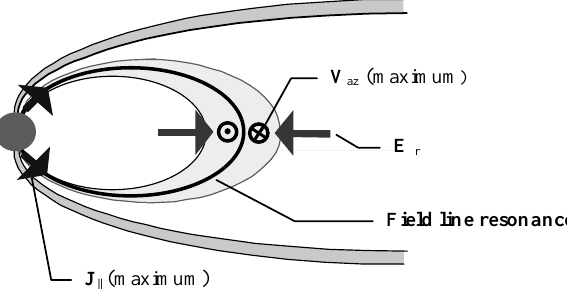
Fig. 1. A schematic of an FLR in the near-Earth magnetotail. The outer shaded region is the plasma sheet boundary layer. The inner shaded region is the earthward edge of the plasma sheet, where pre- cipitating energetic hydrogen ions (10 s of keV) give the H- β band seen in the MPA data.